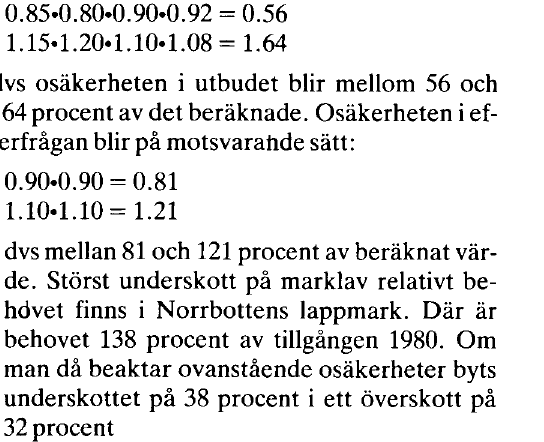
Tabell 3.5. Vården som anvånts vid kånslighetsana- lys, procent av grundvården Figures used for sensitivity analysis, per cent of basic